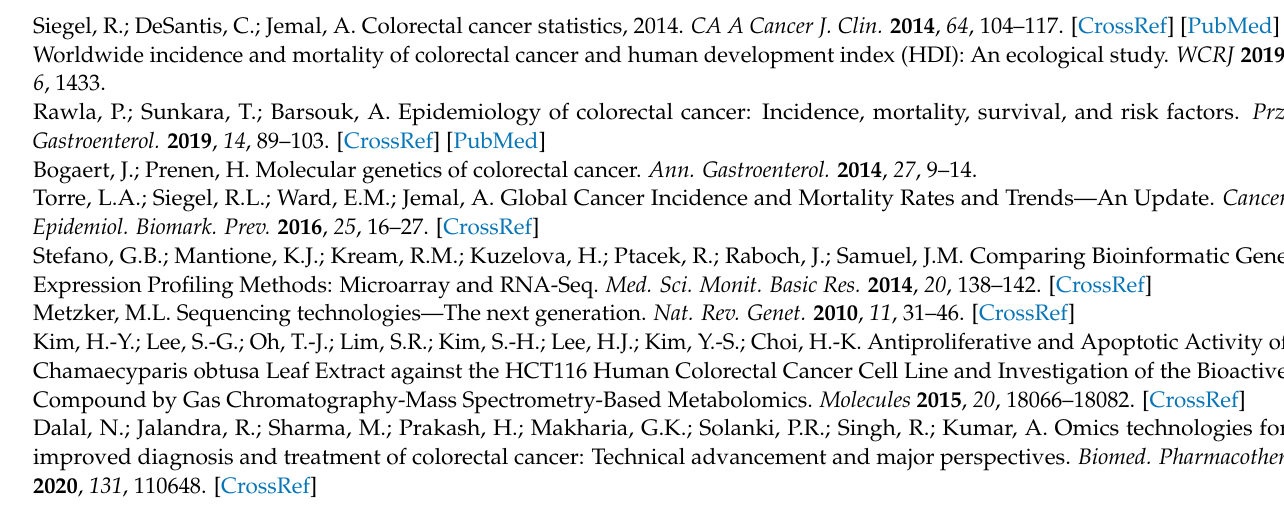
Table S2. List of identified differentially expressed genes and their respective p -values, and the